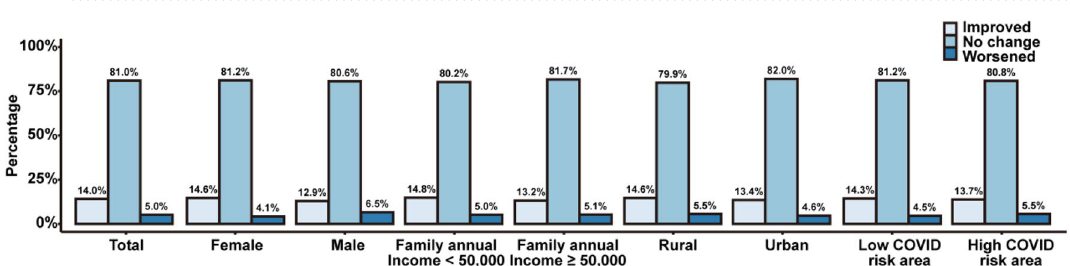
Figure 4. The change of sleep quality by sex, family income, urban/rural areas, and COVID-19 risk areas between 2019 and 2020. Notes: Statistically significant difference was found in total ( p -value < 0.001), and all the subgroups ( p -value <